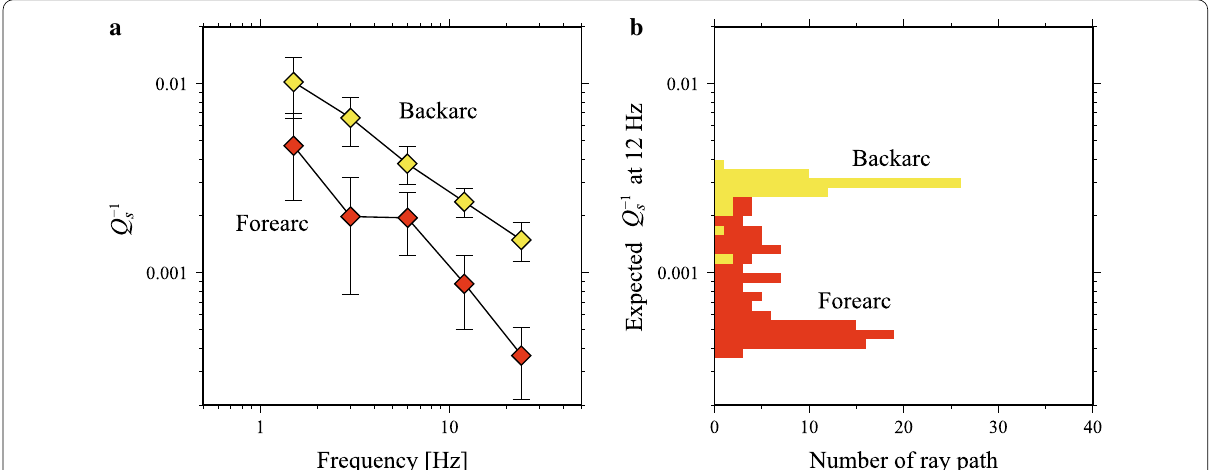
Fig. 9 a Estimated path-averaged Q − 1 S values of the direct S waves of backarc intraslab earthquakes. Squares and error bars represent the median Q − 1 S values and their interquartile ranges, respectively. b Histograms of path-averaged Q − 1 S values of the direct S waves of backarc intraslab earthquakes at 12 Hz, determined from the assumed attenuation structures in this study (e.g., Fig.